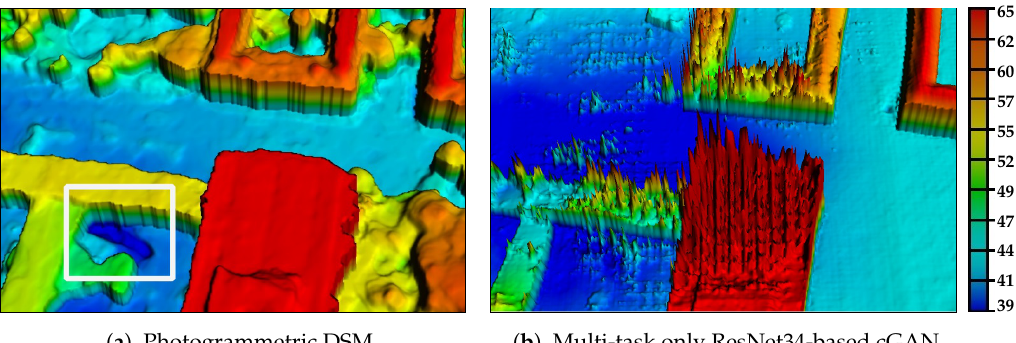
Figure 4. A detailed demonstration of a failure case on the generated LoD2-like DSM obtained by the ResNet34-based network Figure 2a architecture. ( a ) depicts the input photogrammetric DSM, and ( b ) shows the resulted ResNet34-based DSM from Figure